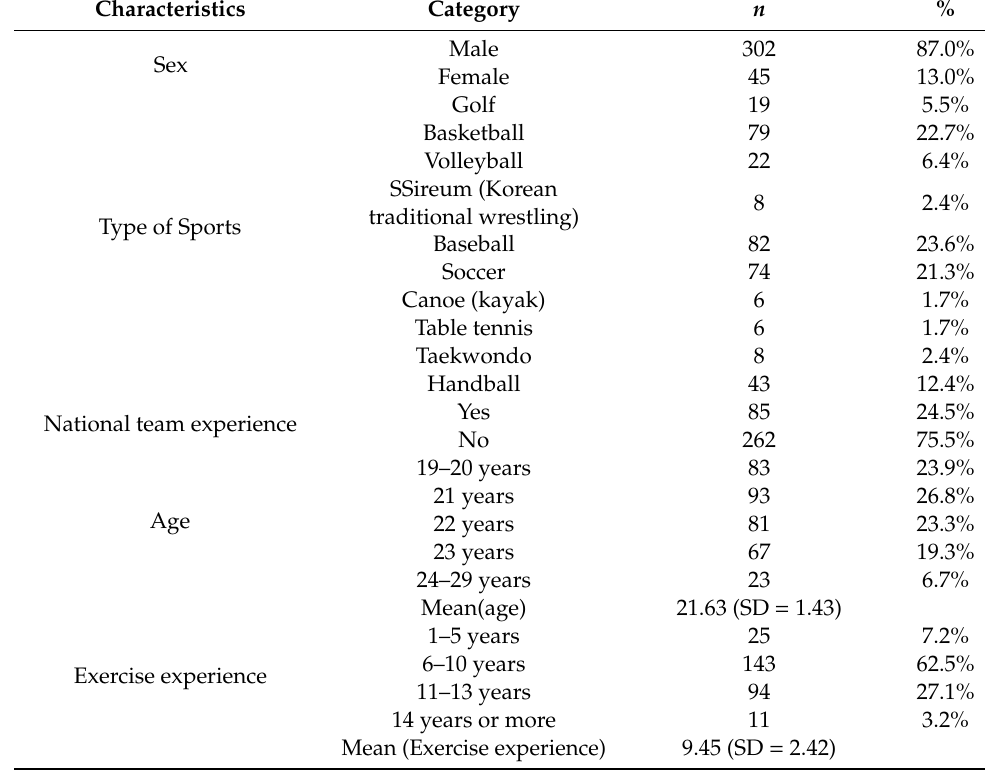
Table 1. Breakdown of research